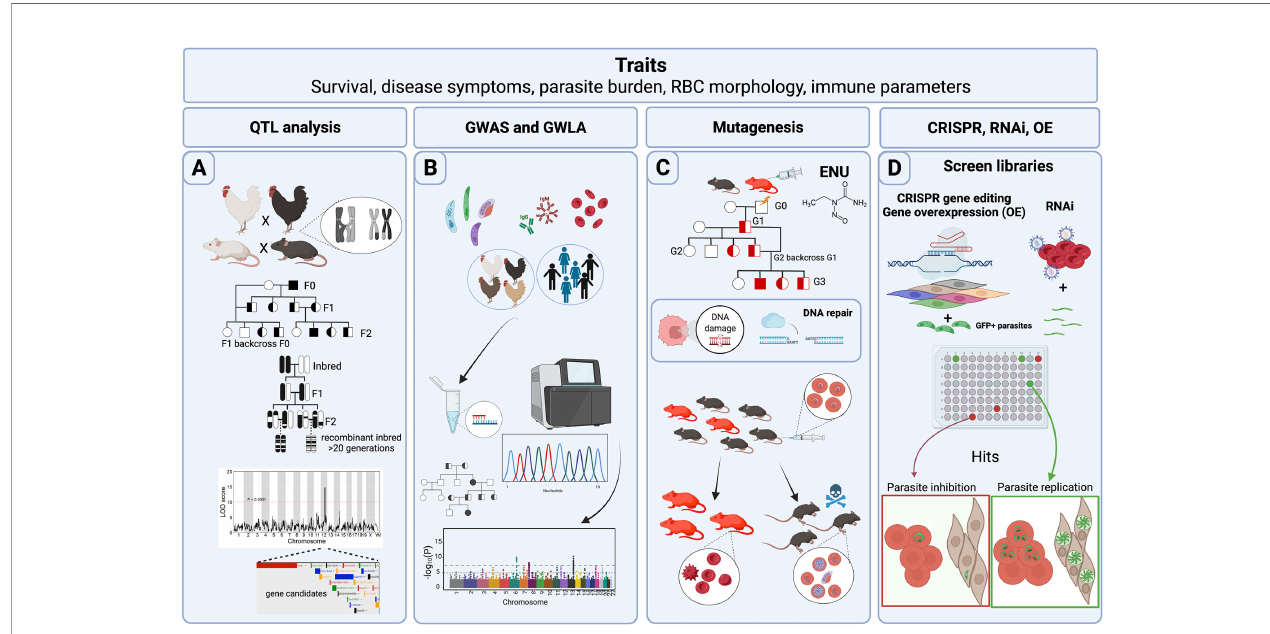
FIGURE 1 | Host forward genetic screens in Apicomplexa. Common traits measured in forward genetic screens (FGS) are survival to Apicomplexa infection, symptoms related to the disease such as fever or tissue pathology, prevalence of the disease within a population, parasite load reduction, variables such as red blood cell (RBC) morphology and physiology, and immune parameters such as cytokines and parasite-speci fi c antibody titers. (A) Classical genetic approaches use crosses between different genetic backgrounds that differ in susceptibility to infection. Rodents, pigs, and chickens have been analyzed for quantitative trait loci (QTLs) following Apicomplexa infection. In addition, more complex crosses of mice including backcrosses of murine recombinant inbred lines (RILs), or more advanced populations of RILs have been used to generate QTLs with narrow regions of association. The fi nal objective is to map genomic regions and identify variants associated with the trait. Data is frequently represented as a QTL map showing peaks over the genetic regions with highest trait association. Candidate genes are usually indicated within the QTL. (B) Genome-wide association studies (GWAS) and genome-wide linkage analysis (GWLA) seek genotype-phenotype correlations for a variety of traits associated with disease caused by Apicomplexa; humans and chickens have been subjected to these approaches. These screens rely on a high quantity of genetic markers, or SNPs that are determined by differential oligo binding or whole genome sequencing of individuals enrolled in the study. Associations are visually displayed using Manhattan Plots, showing strength of the probability (-Log10(P)) and the chromosomal localization of the SNPs. (C) ENU mutagenesis screens are designed to generate 1 mutation in every 700 loci and relies upon small failures of the host ’ s DNA repair machinery. Mutagenesis screens start with a male treated with ENU and crossed with healthy females. Various breeding schemes can be used to segregate the gene causative of the induced trait ( e.g. protection against Plasmodium infection). (D) CRISPR, RNAi, and gene overexpression (OE) library screens are adapted for high-throughput in vitro conditions, and can screen hundreds or thousands of genes during the process. CRISPR and RNAi inhibit while OE enhances gene function through overexpression. GFP+ parasites are often used to measure parasite proliferation to help identify host genes capable of inhibiting or promoting parasite replication and growth. Credits: Figure created in